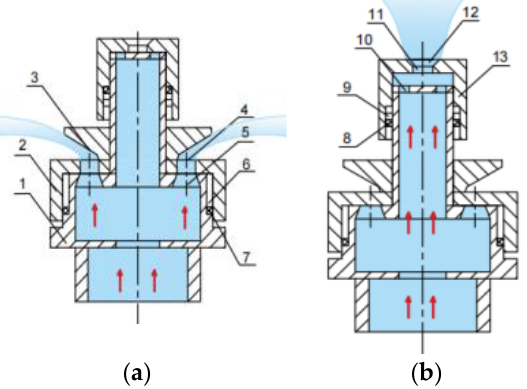
Figure 1. Two working models of the sprinkler. 1. Sprinkler body. 2. Rotating shell body. 3. Refractive surface. 4. Outlet nozzle. 5. Diversion hole. 6. First limit slot. 7. First limit pin. 8. Second limit pin. 9. Second limit slot. 10. Diversion chute. 11. Nozzle. 12. Outer cone angle. 13. Nozzle cap. ( a ) Irrigation water model; ( b ) Pesticide-spraying model.